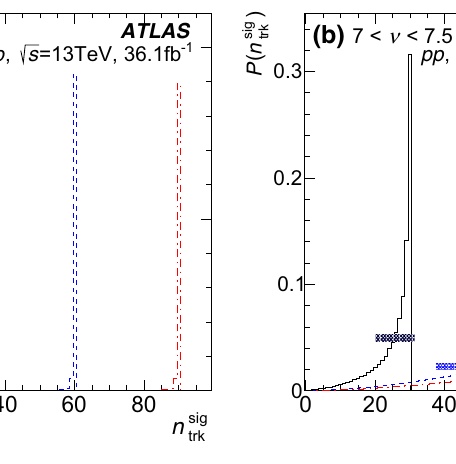
Fig. 7 The probability of a Signal event with multiplicity n sig tribute to a Direct event with n dir and dotted-dashed), as a function of n sig